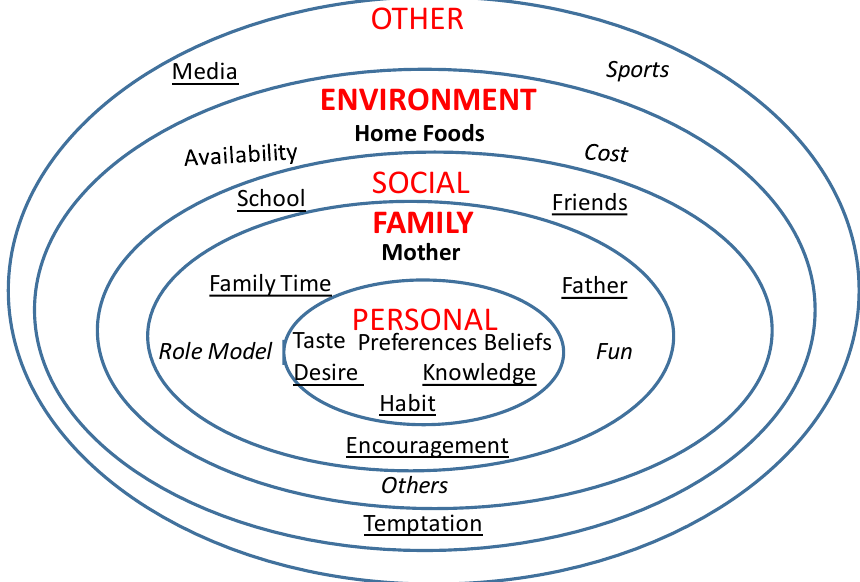
Figure 2. Children’s thematic network. Legend: Majority of children mentioned– bold font; many/most mentioned—regular font; some mentioned– underlined font; few mentioned—italicized font. Table 2. Themes mentioned by the majority of parents and children within each level of influence.